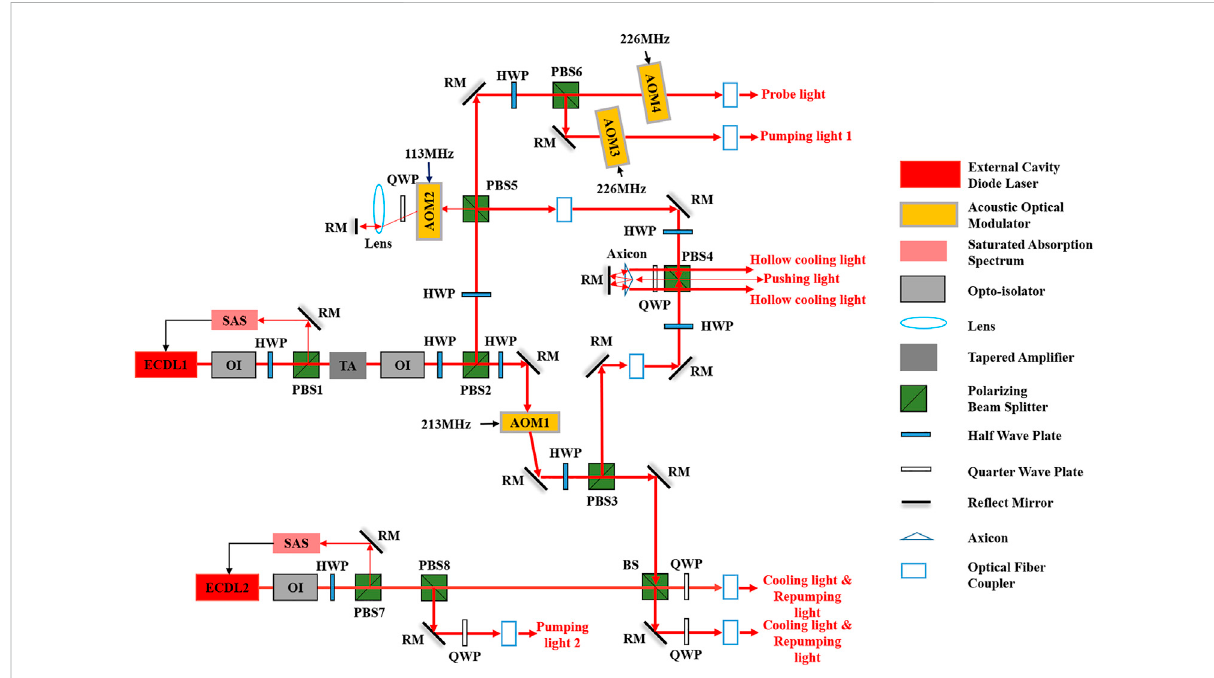
FIGURE 3 Schematic of the optical system of the optically pumped cold cesium beam atomic clock. Both ECDLs were frequency stabilized using a saturable absorption spectrum. All of the lasers were fi nally coupled into the fi ber and output to the desired location. OI: optical isolator; HWP: λ / 2 wave plate; PBS: polarizing beam splitter prism; RM: mirror; SAS: saturable absorption spectrum; TA: tapered ampli fi er; AOM: acousto-optic modulator; QWP: λ /4 wave lens: convex lens; BS: beam splitter